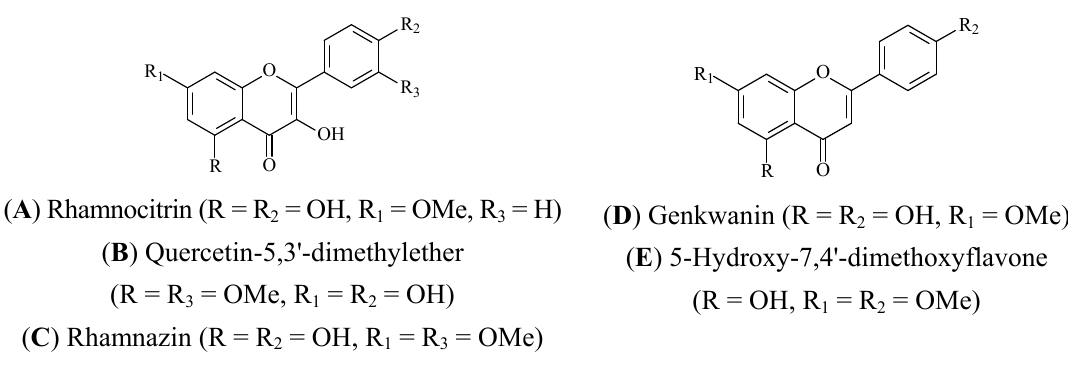
Figure 1. The molecular structures of compounds isolated from Combretum